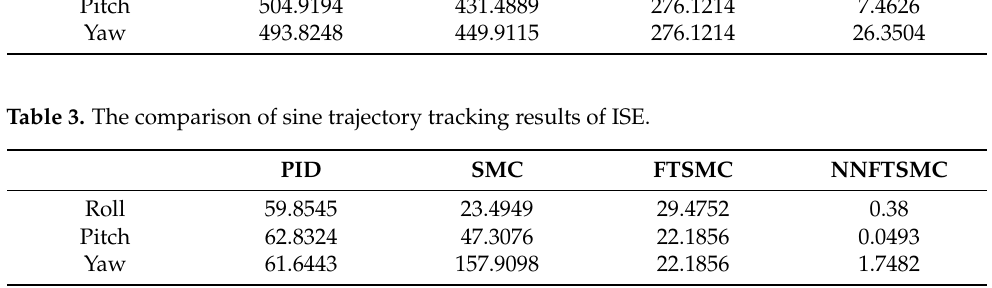
Figure 10. The angular velocity of the platform by using different controllers in the simulation of